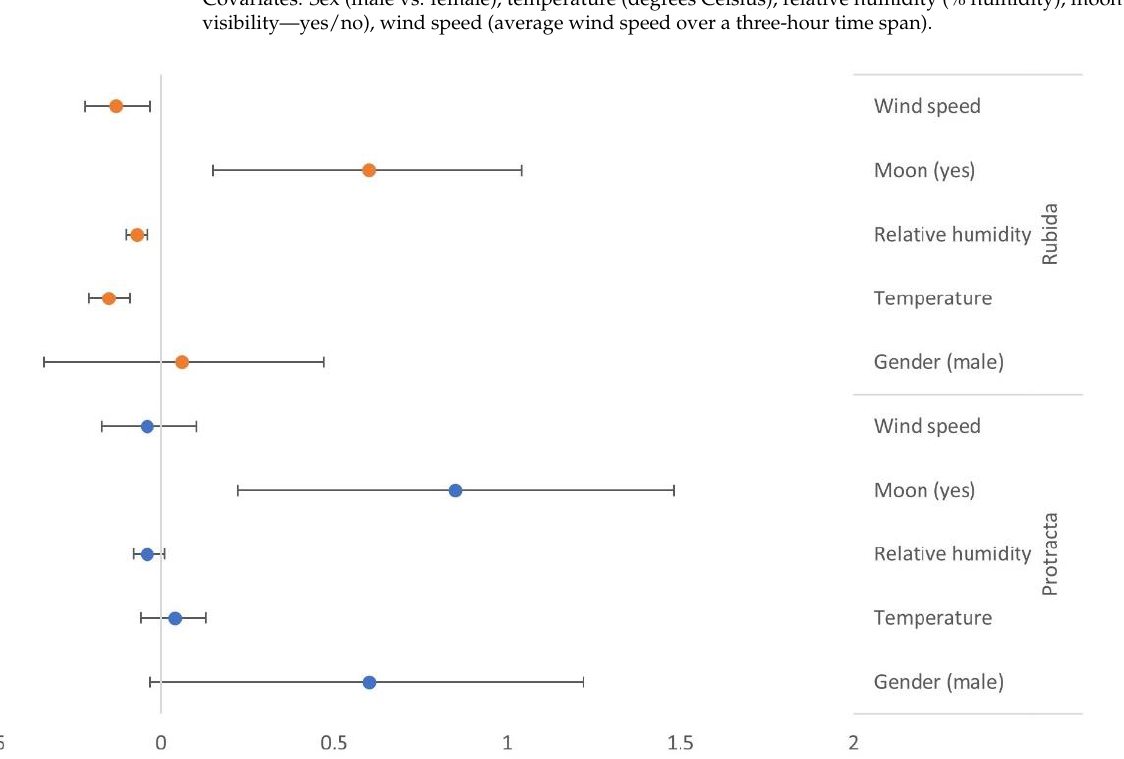
Table 1. Results of negative binomial regression for kissing bug flight count from 6 May 2020 to 17